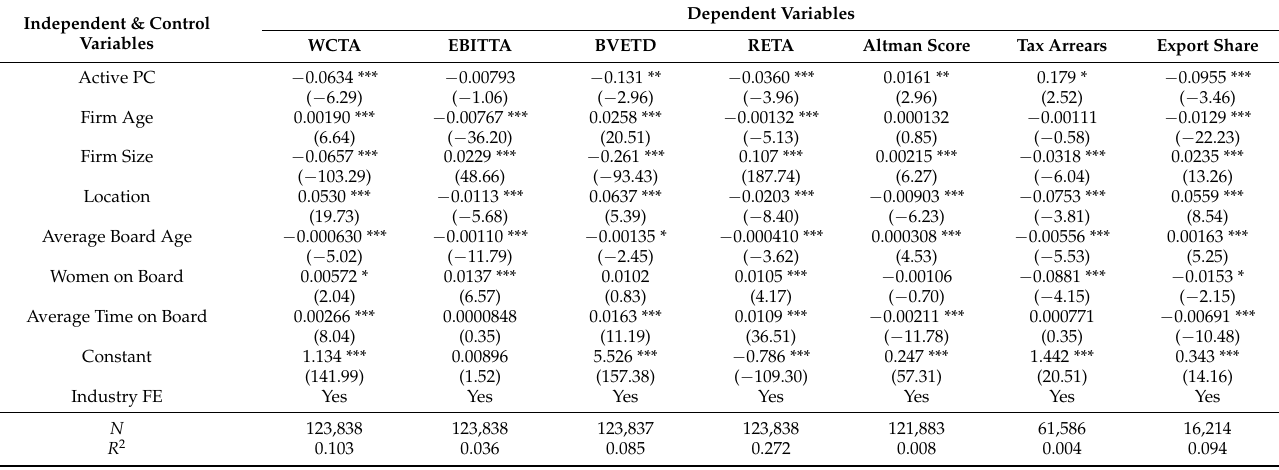
Table A4. OLS regressions with seven different dependent variables (year 2017) and Active PC as the independent